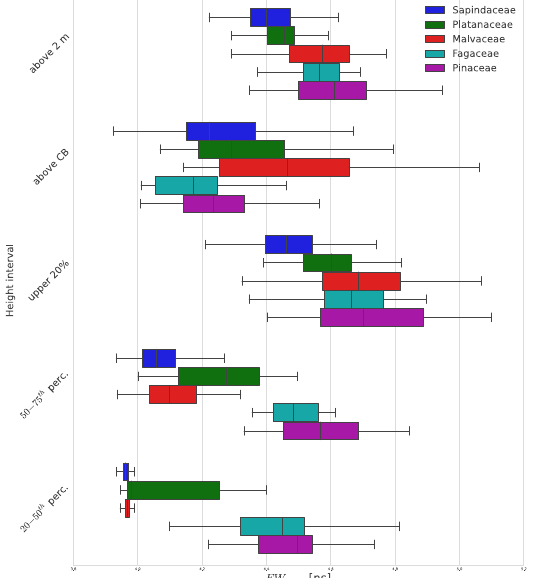
Figure 6. The mean echo width differentiated by tree family and related to different height intervals